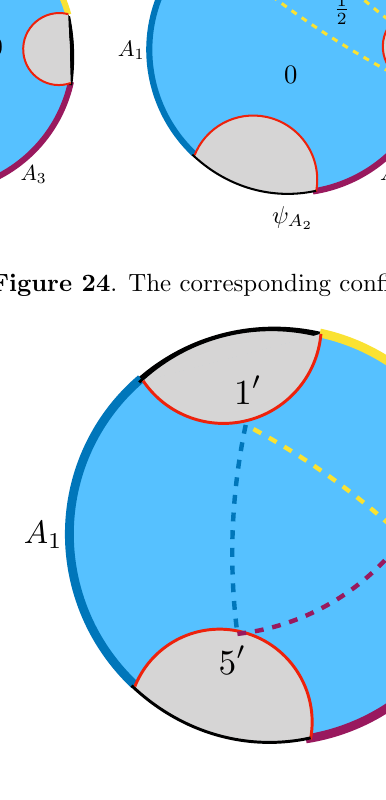
Figure 25 . An integer surface